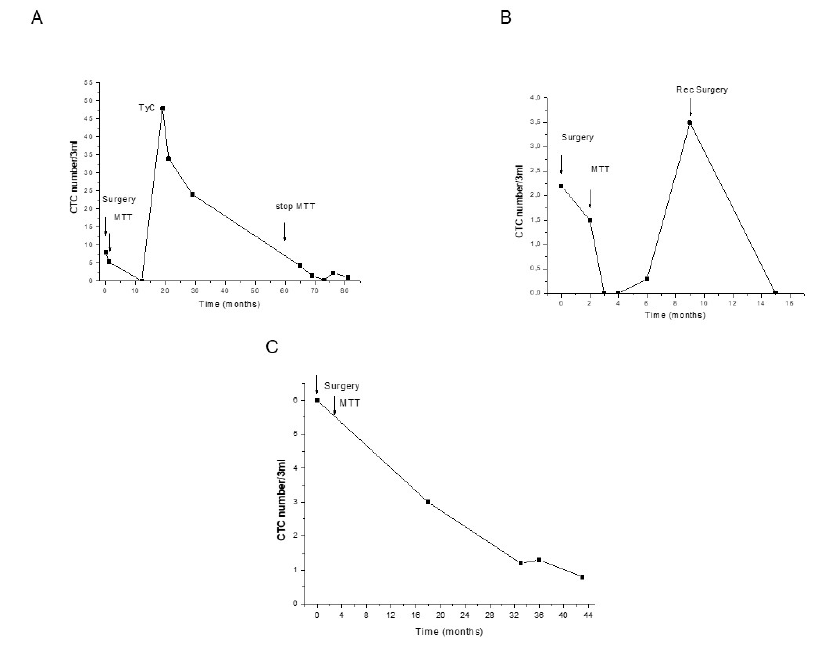
Figure 3. Distribution of CTCs in blood samples during the follow-up of three representative ACC patients. The numbers of CTCs separated and counted on ScreenCell filters in each blood sample at the indicated time of follow ‐ up are represented. Arrows indicate T = 0 corresponding to tumor removal (surgery), the initiation of mitotane (MTT) therapy and the stop of therapy at five years from surgery (60 months). ( A ) patient, stage II, R0; ( B ) patient, stage III, R0, the additional arrow indicates surgery for a retroperitoneal lymph node diagnosed at month 6; ( C ) patient stage III, R0. A statistically significant negative association was found between MTT and CTCs in the three patients considered, where MTT levels and CTCs were evaluated in blood samples drawn on the same day (Figure 4). Cancers 2020 , 12 , x FOR PEER REVIEW